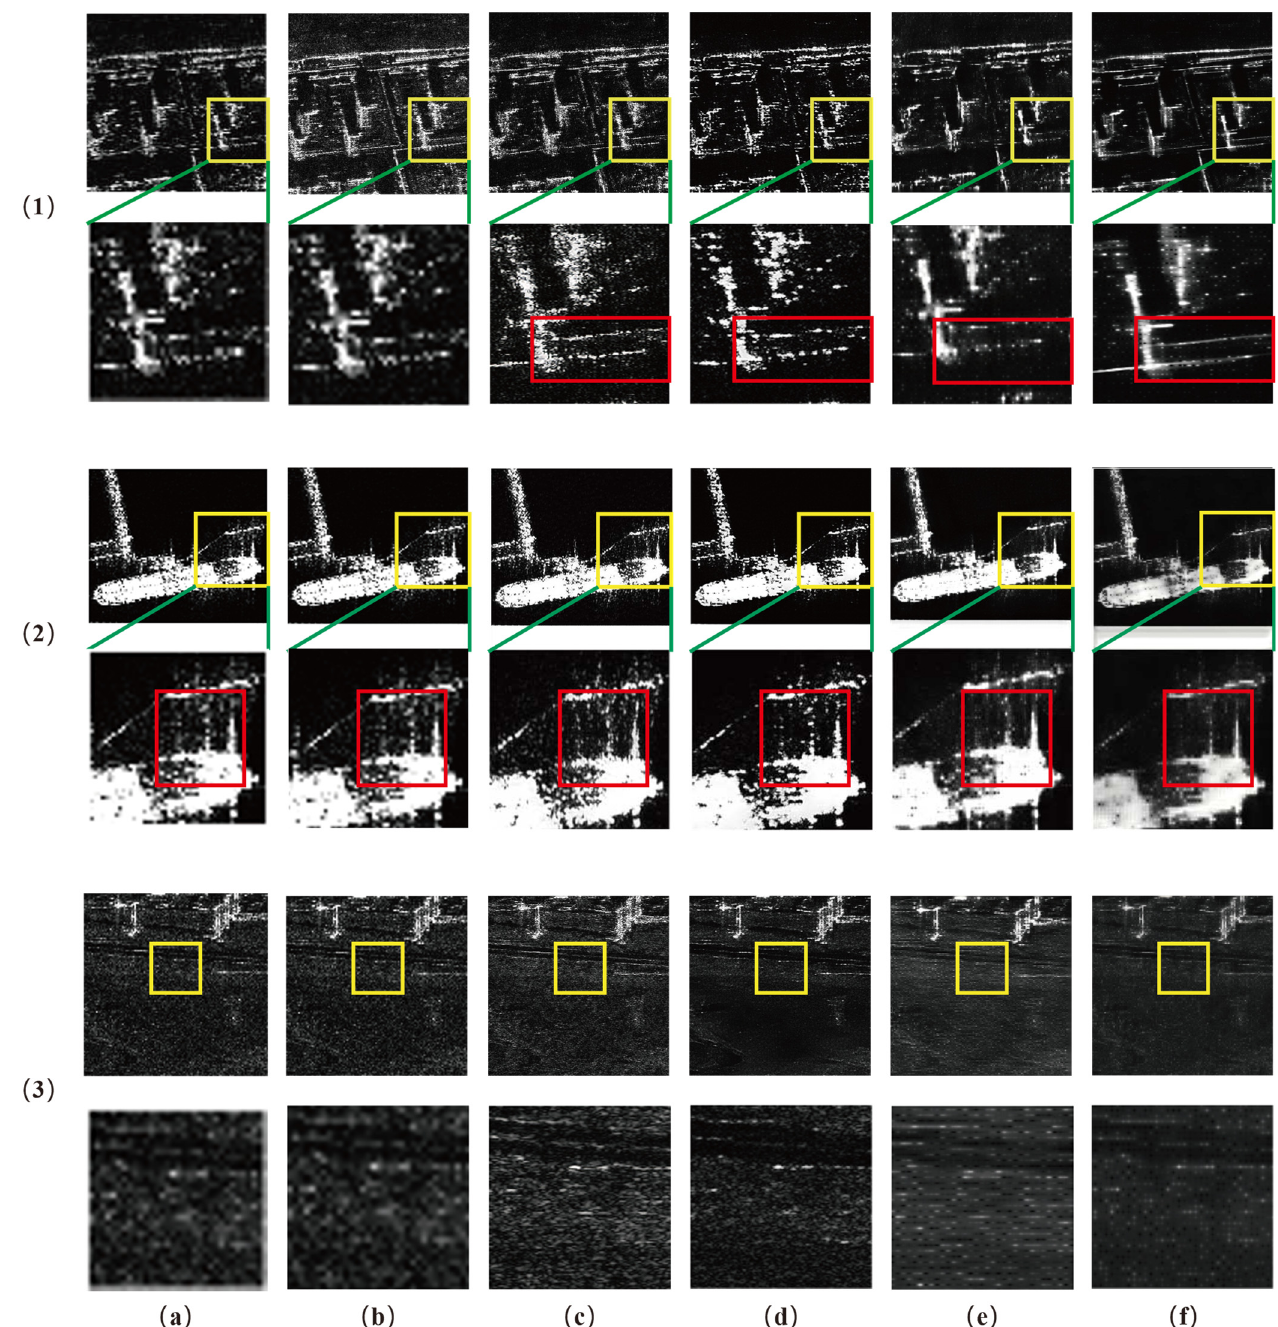
Figure 6. Visual results of synthetic SAR image dataset. The second row is the enlarged view of the first row in each of three paired pictures. ( a ) Input image (bicubic down-sampling from the HR image). ( b ) Bicubic interpolation. ( c ) SNGAN. ( d ) Real ESRGAN. ( e ) PDM-SR. ( f ) The proposed method. (1)–(3) represent three pairs of examples to illustrate the performance. The second row of each pair of examples is the enlarged view of the corresponding yellow box in the first row. The red boxes show the outstanding performance of the proposed method in recovering texture and de-noising.